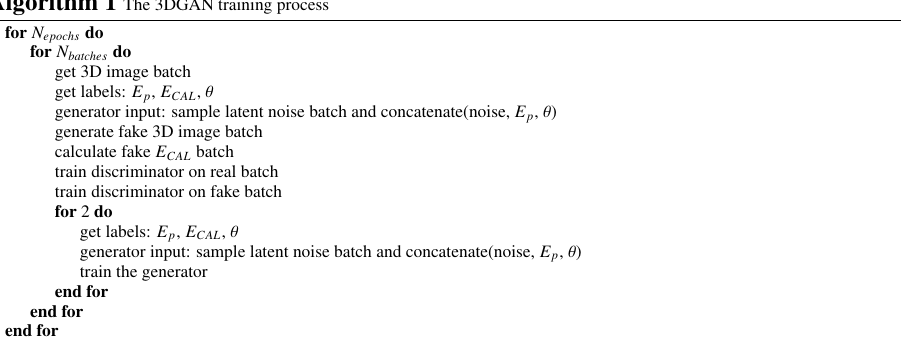
Algorithm 1 The 3DGAN training